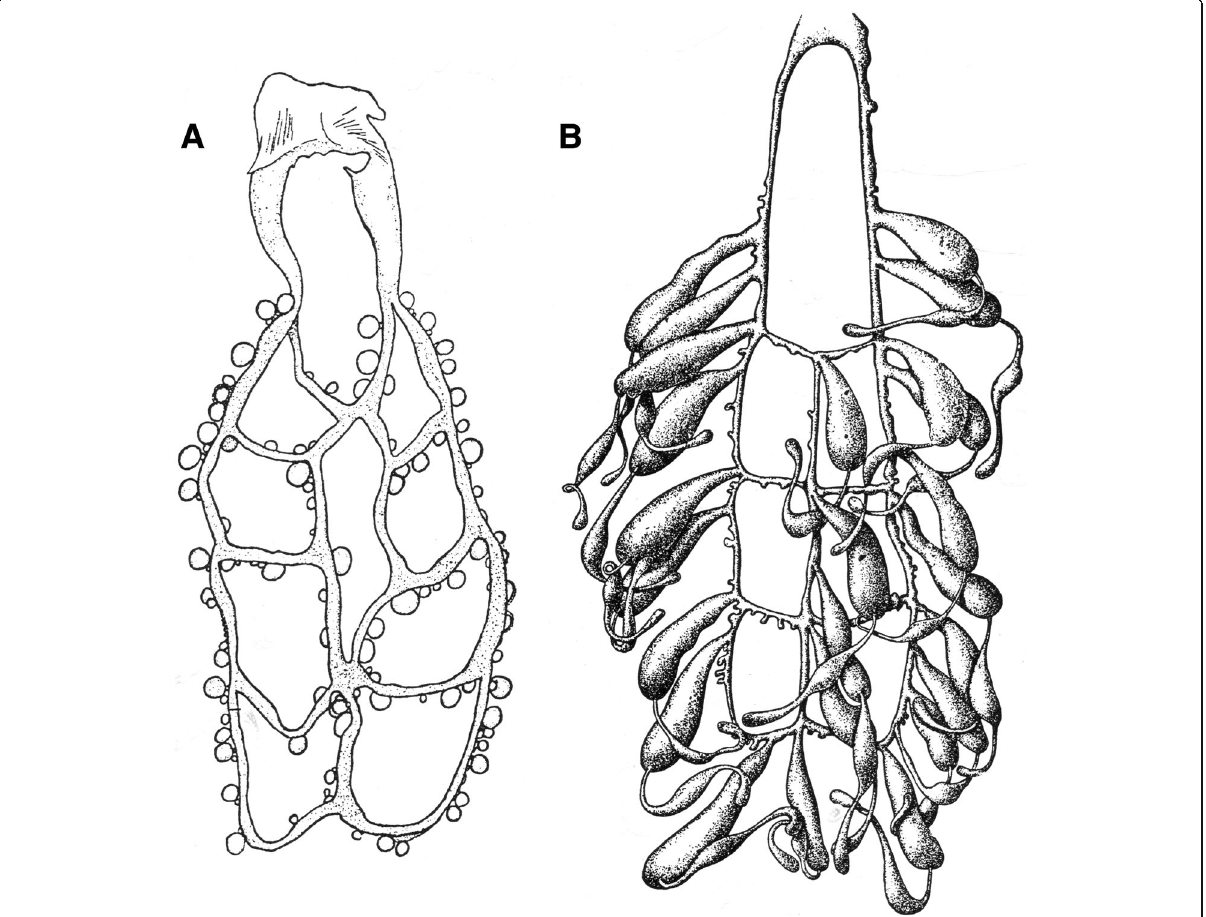
Fig. 2 Ovariuterus in dorsal aspect of ( a ) Rhopalurus rochai (apoikogenic species) and ( b ) Scorpio maurus (katoikogenic species). Modified as described by Matthiersen [29] and Millot and Vachon